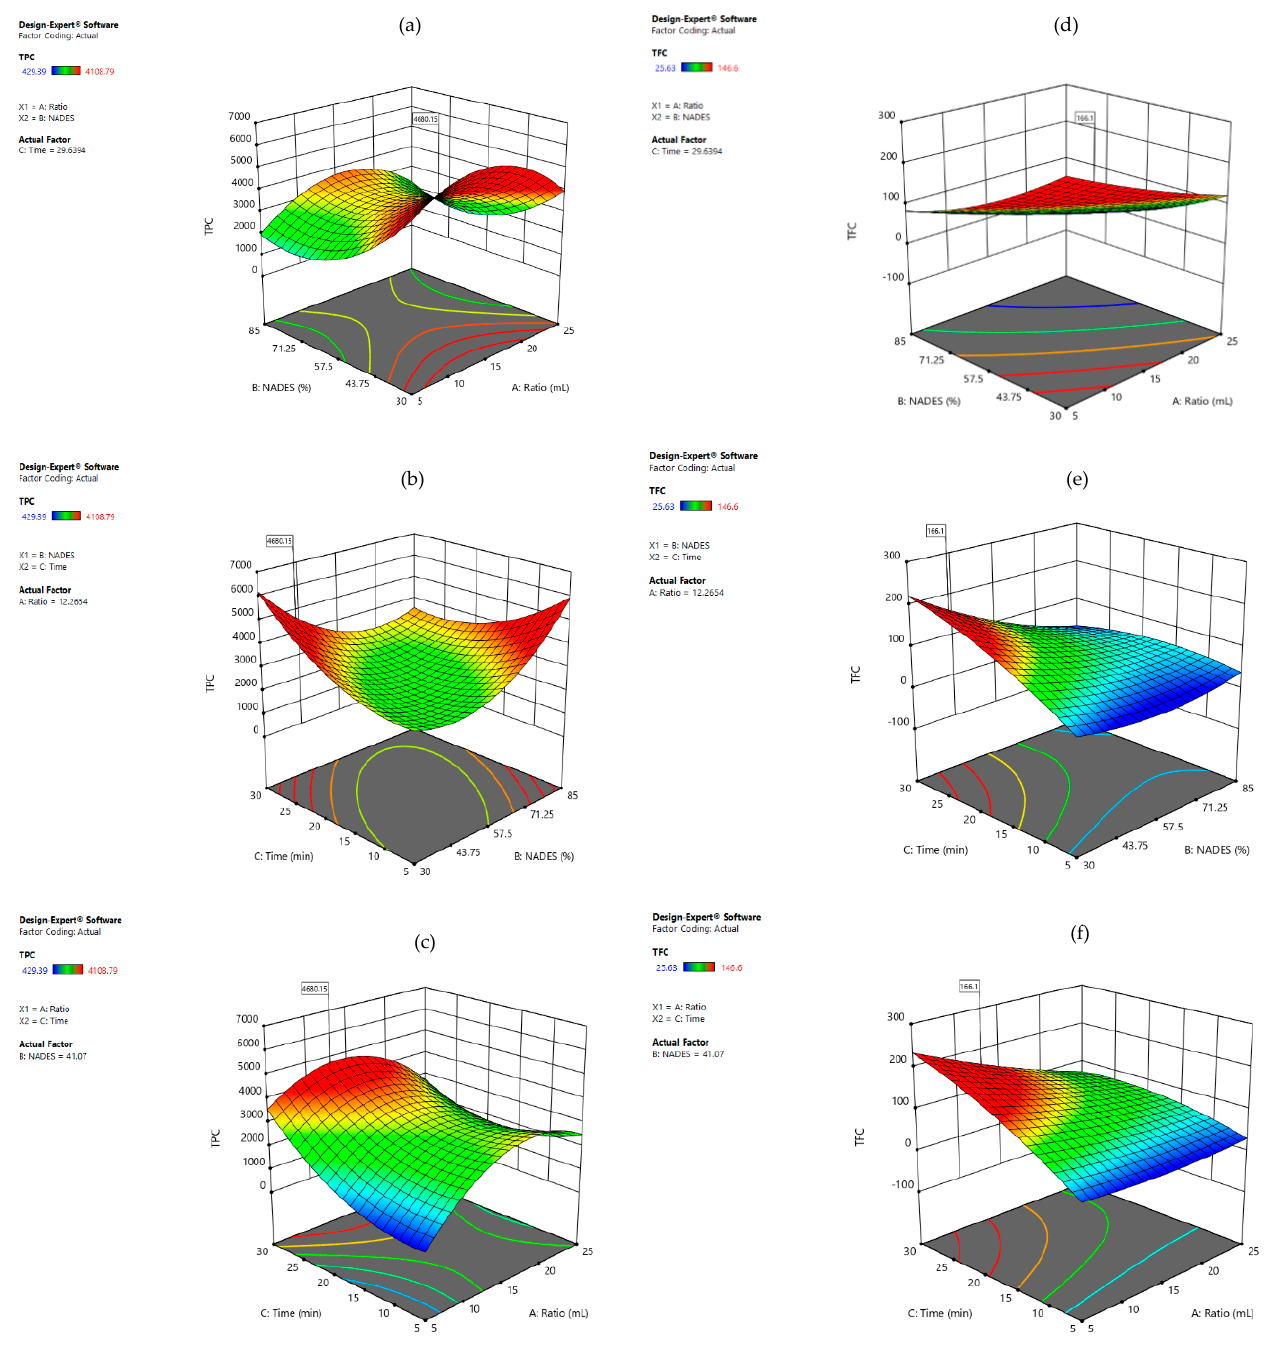
Figure 4. Response surface plots showing combined effects of solid:liquid ratio, %NADES, and extraction time for TPC ( a – c ) and TFC ( d – f ) with LP:MA as solvent.